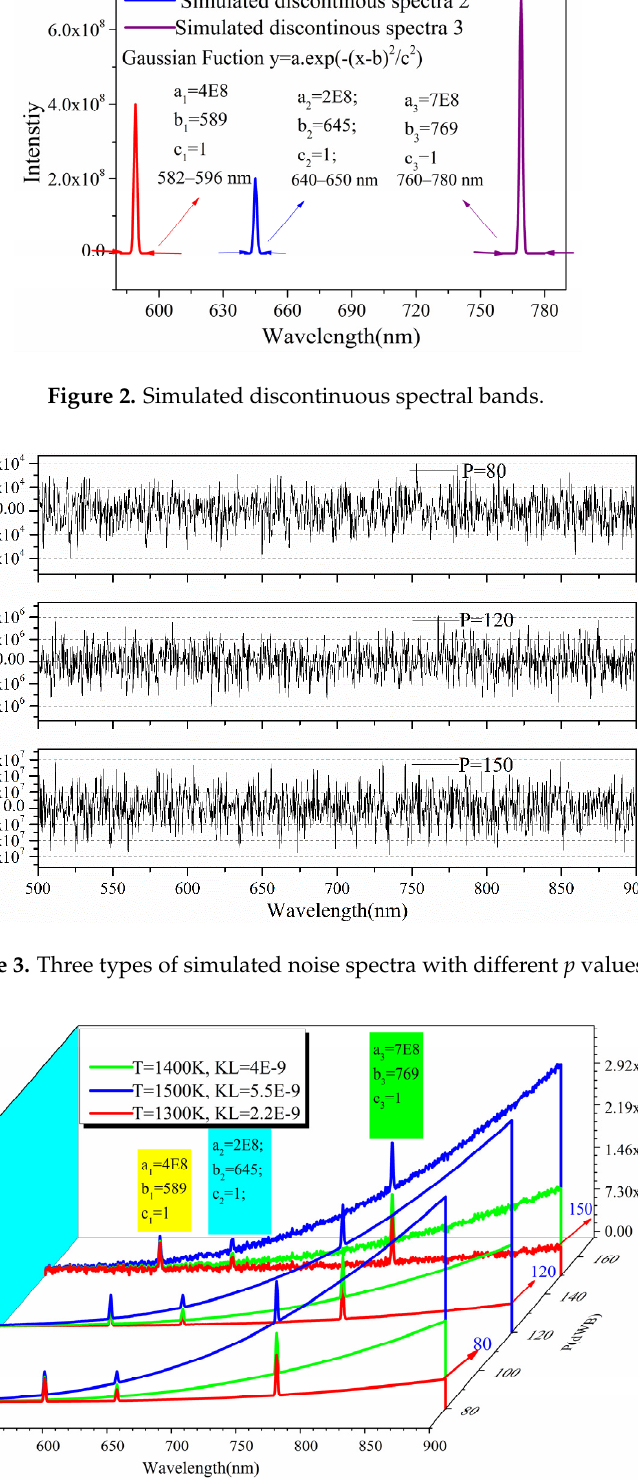
Figure 4. Nine simulated flame radiation spectra for different types of white noise.